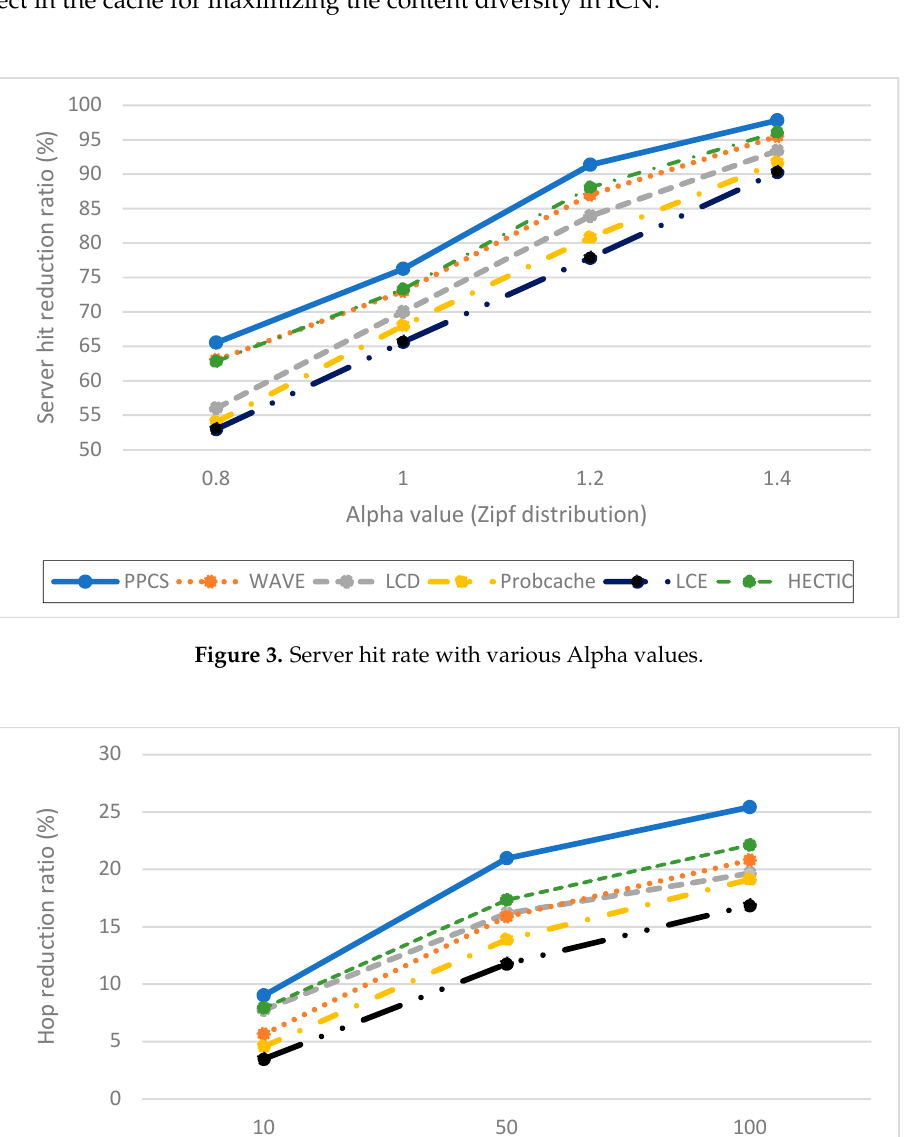
Figure 6. Cache diversity enhanced ratio corresponding to different Alpha values (compared to LCE with LRU). Overall, for all the evaluated metrics, PPCS consistently outperforms all other alternative approaches and greatly diminishes content cache redundancy through a wide range of content popularity distributions (Zipf) and CN cache sizes. Specifically, PPCS removes the tail chunks of unpopular content objects due to their negligible significance to reduce the size and number of unnecessary exchanged packets. Since the unpopular content with low utility can still be retrieved from the content producer, this does not result in degraded performance. The evaluation results then show that PPCS achieves the best performance over other related current caching schemes in minimizing network resource (cache storage) and cache redundancy to optimize cache utilization in ICN. The reason is that PPCS facilitates the efficient data transmissions via the edge layer and distributed processing among the on-path nodes in ICN. Given that an efficient caching scheme can reduce energy consumption by diminishing the traffic load via enhanced cache efficiency, as shown in our prior studies [4,40], the proposed popularity-aware caching scheme can be considered a scalable and feasible ICN caching approach for the FI implementation.